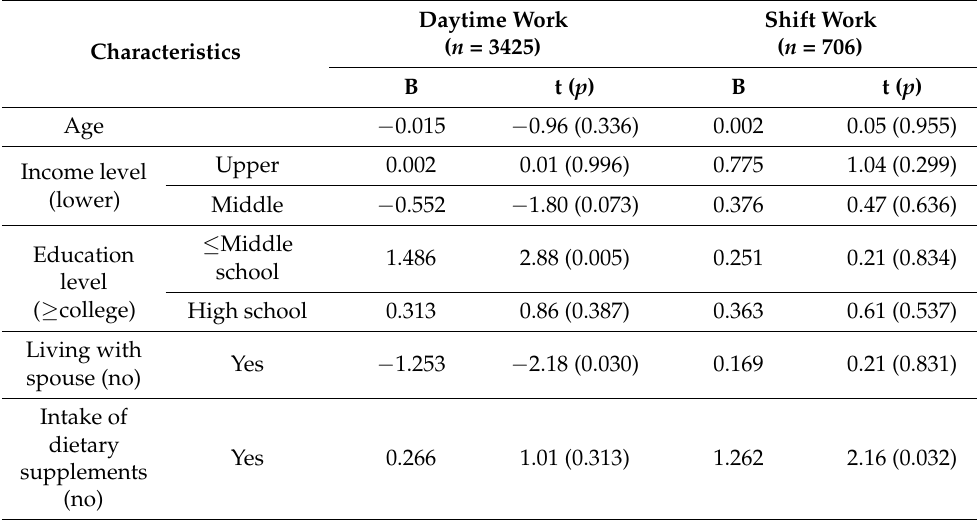
Table 3. Factors affecting of HRQoL ( n =